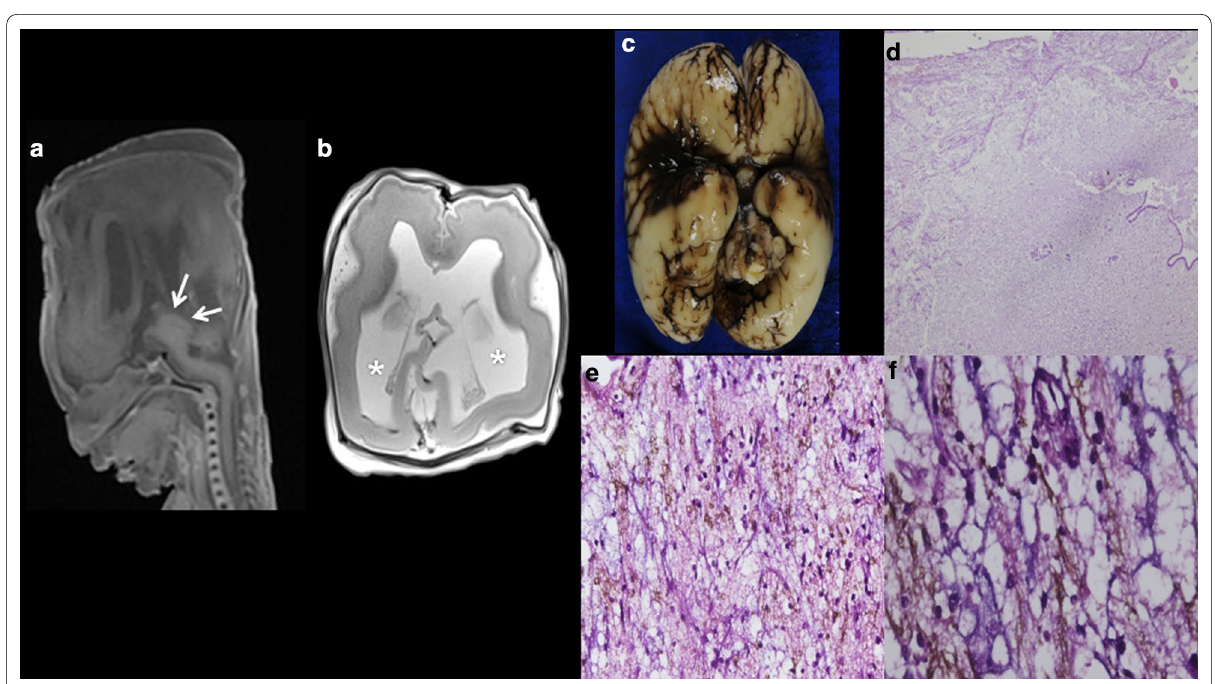
Fig. 12 DNET in a 24‑week foetus with elective termination of pregnancy. ( a ) Sagittal T1W MRI, ( b ) axial T2W MRI showing ventriculomegaly (asterisks) and a dysplastic mesencephalon (arrows), which were the cause of TOP. c Macroscopic specimen. d Tumour with DNET features involving the brainstem with infiltration of the Silvius aqueduct (H/E, 4). e , f Double staining showing positivity for neurofibrils (immunohistochemistry × against neurofibrils, in brown) intermingled with mucoid material (alcian blue, in blue) in the tumour ( 40 and × ×